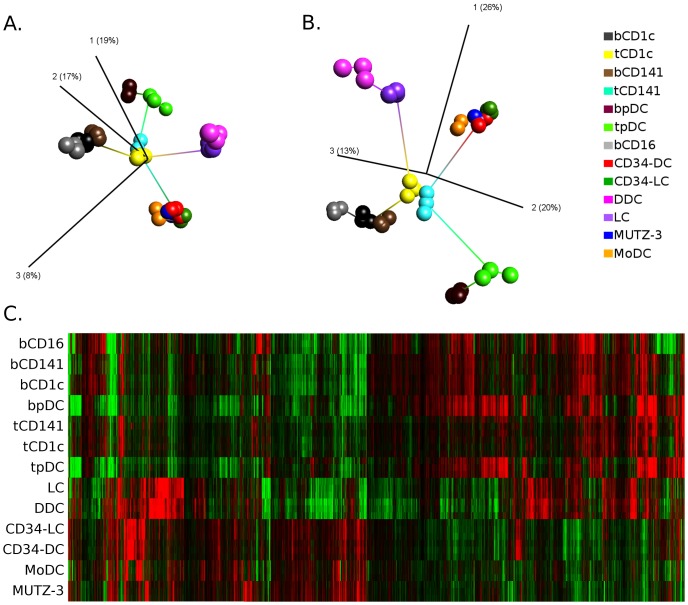
Resemblance of in vitro DC models with skin, tonsillar and peripheral blood DC populations.Resemblance demonstrated by principal component analysis (PCA) of expressed transcripts (A. 51,191) and differentially expressed transcripts (B, 18,590) identified by ANOVA p<10−6 (corresponding to p<0,05 after Bonferroni correction). Replicate similarities visualized using k-Nearest Neighbors (k-NN) algorithm (k = 2 in this case) and relationships between cell types demonstrated by minimal spanning tree analysis (lines connecting the different populations). Axes (marked 1, 2 and 3) correspond to the three main components in the PCA analysis and numbers in brackets correspond to percentage of total variation contained within each component. C) Heatmap visualizing gene expression profiles of differentially expressed genes (18,590) upon hierarchical clustering with complete linkage and Euclidean measure. Colors represent high (red) and low (green) normalized intensity.